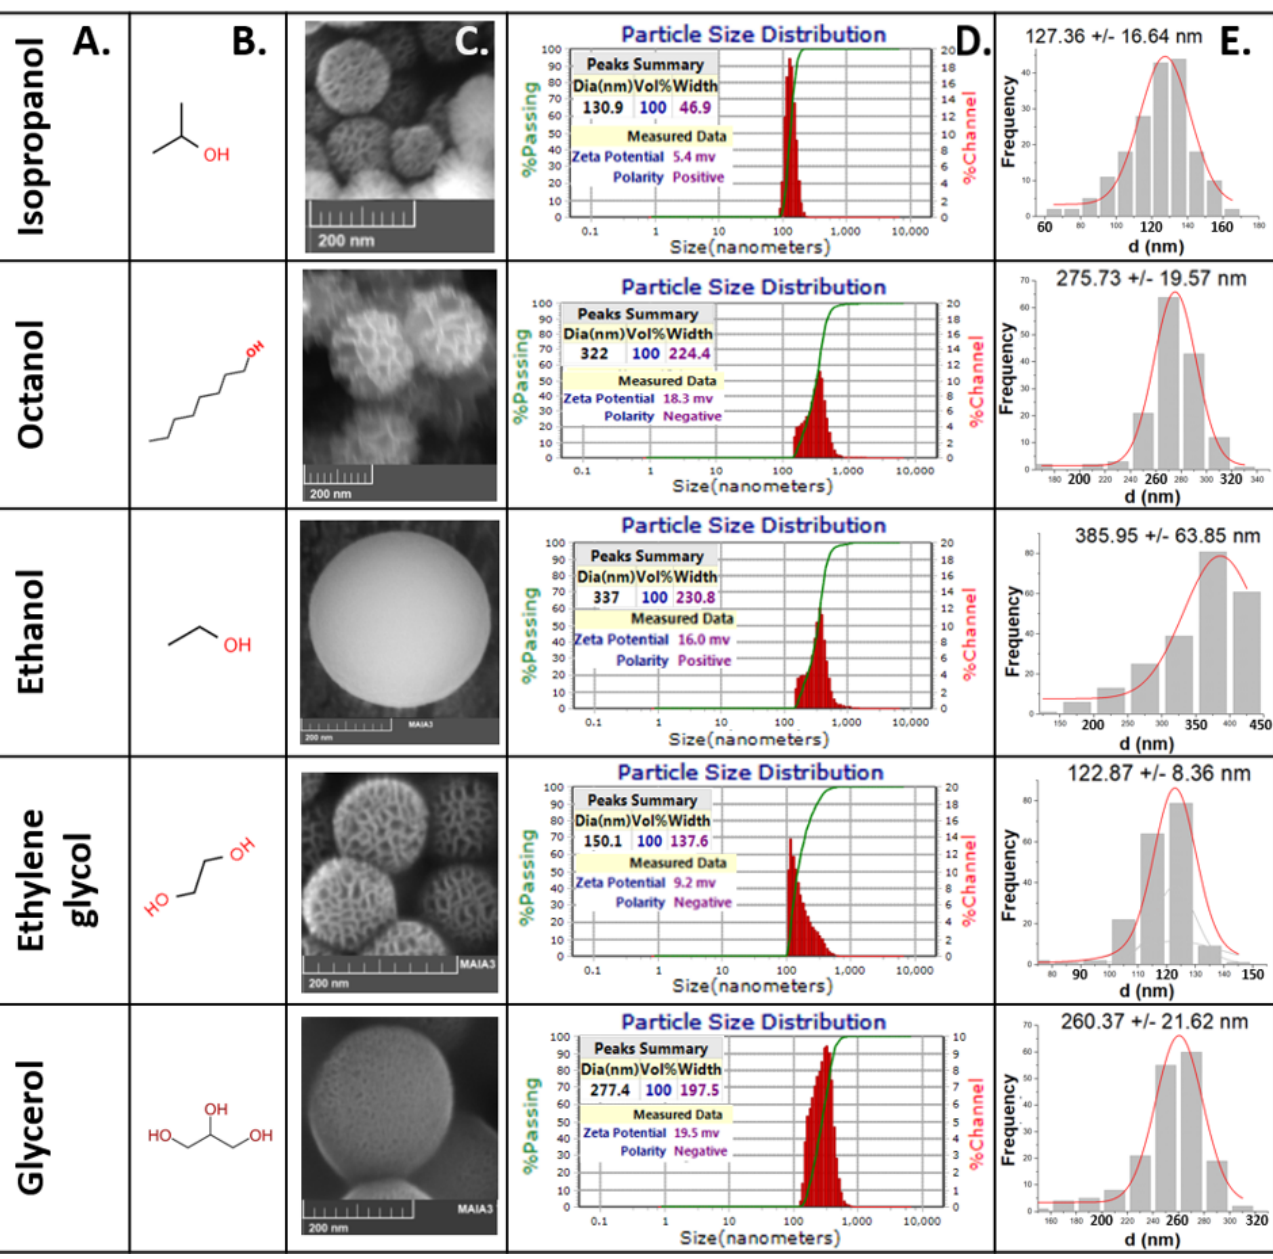
Figure 1. WMS typical homogeneity and size dispersion for different synthesis done with varying co-solvents. ( A ) Co- solvent, ( B ) structure of co-solvent, ( C ) SEM micrographs of WMS nanospheres, ( D ) size dispersion, hydrodynamic radius and Z potential acquired by DLS, and ( E ) scheme 100 nanoparticles from SEM micrographs using ImageJ.